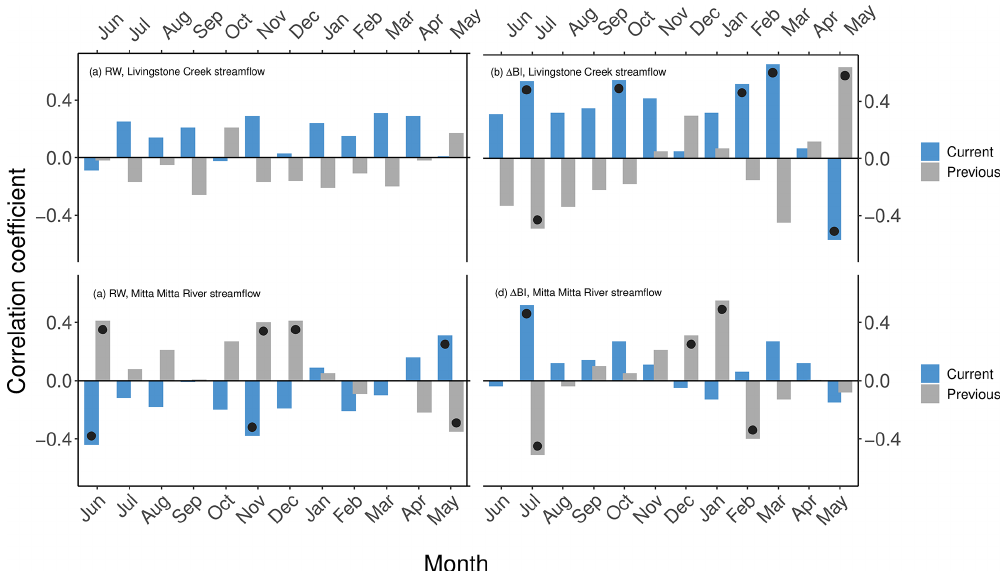
Figure A2. Correlations between RW and (cid:49) BI chronologies and total monthly streamflow (m 3 s − 1 ) at Livingstone Creek at Omeo for the 1968–1994 period and total monthly streamflow (ML) at the Mitta Mitta River at Hinnomunjie across the 1955–1998 period. Black dots indicate statistical significance ( p < 0 .